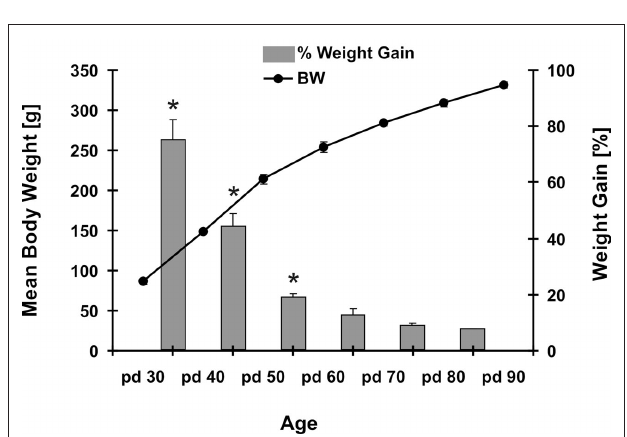
Figure 1 | Mean SCM intake relative to body weight in adolescent rats between age pd 30 and pd 90 (A) and in adult rats (starting at pd 100) (B). SCM intake was increased during early and mid-adolescence (pd 30–60) compared to young adulthood (pd 70–90). A peak was observed on pd 50 that differed significantly from all other testing days. No statistical differences were